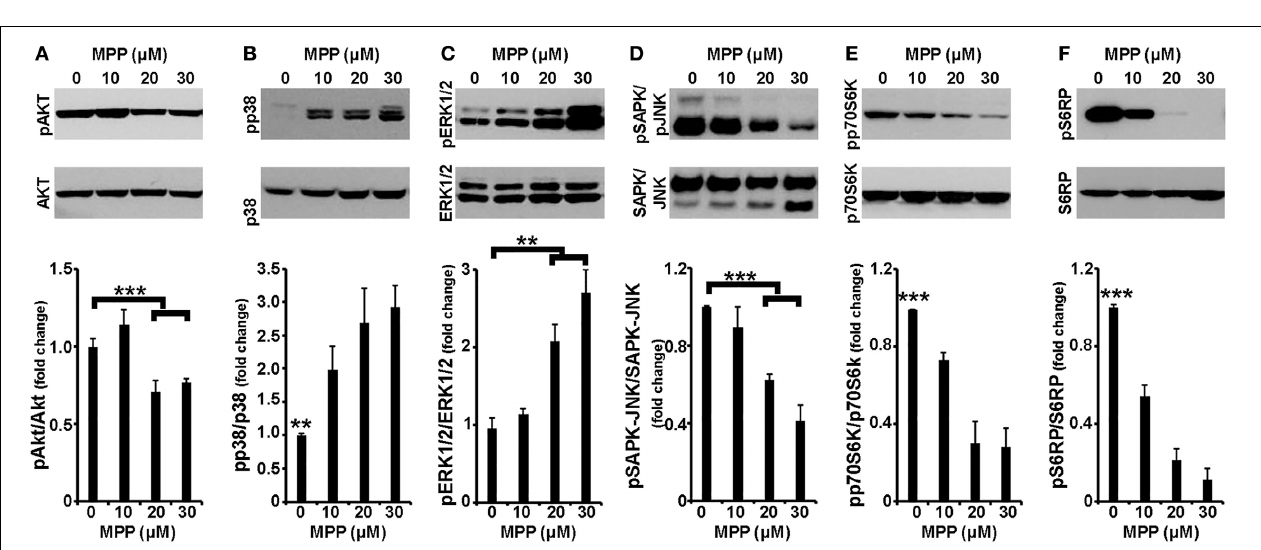
FIGURE 2 | Cortical neurons treated with MPP + displayed alterations in all major intracellular signaling cascades. Seven-day primary cortical neurons were treated with 10, 20, and 30 μ M MPP + for 24h. Equal amounts of total protein from lysates of cortical neurons were analyzed on 10% SDS-PAGE and immunoblotted with antibodies specific for phosphorylated forms of AKT (A) , p38 MAPK (B) , ERK1/2 (C) , JNK/SAPK (D) , p70S6K (E) , as well as for the phosphorylated forms of p70S6K